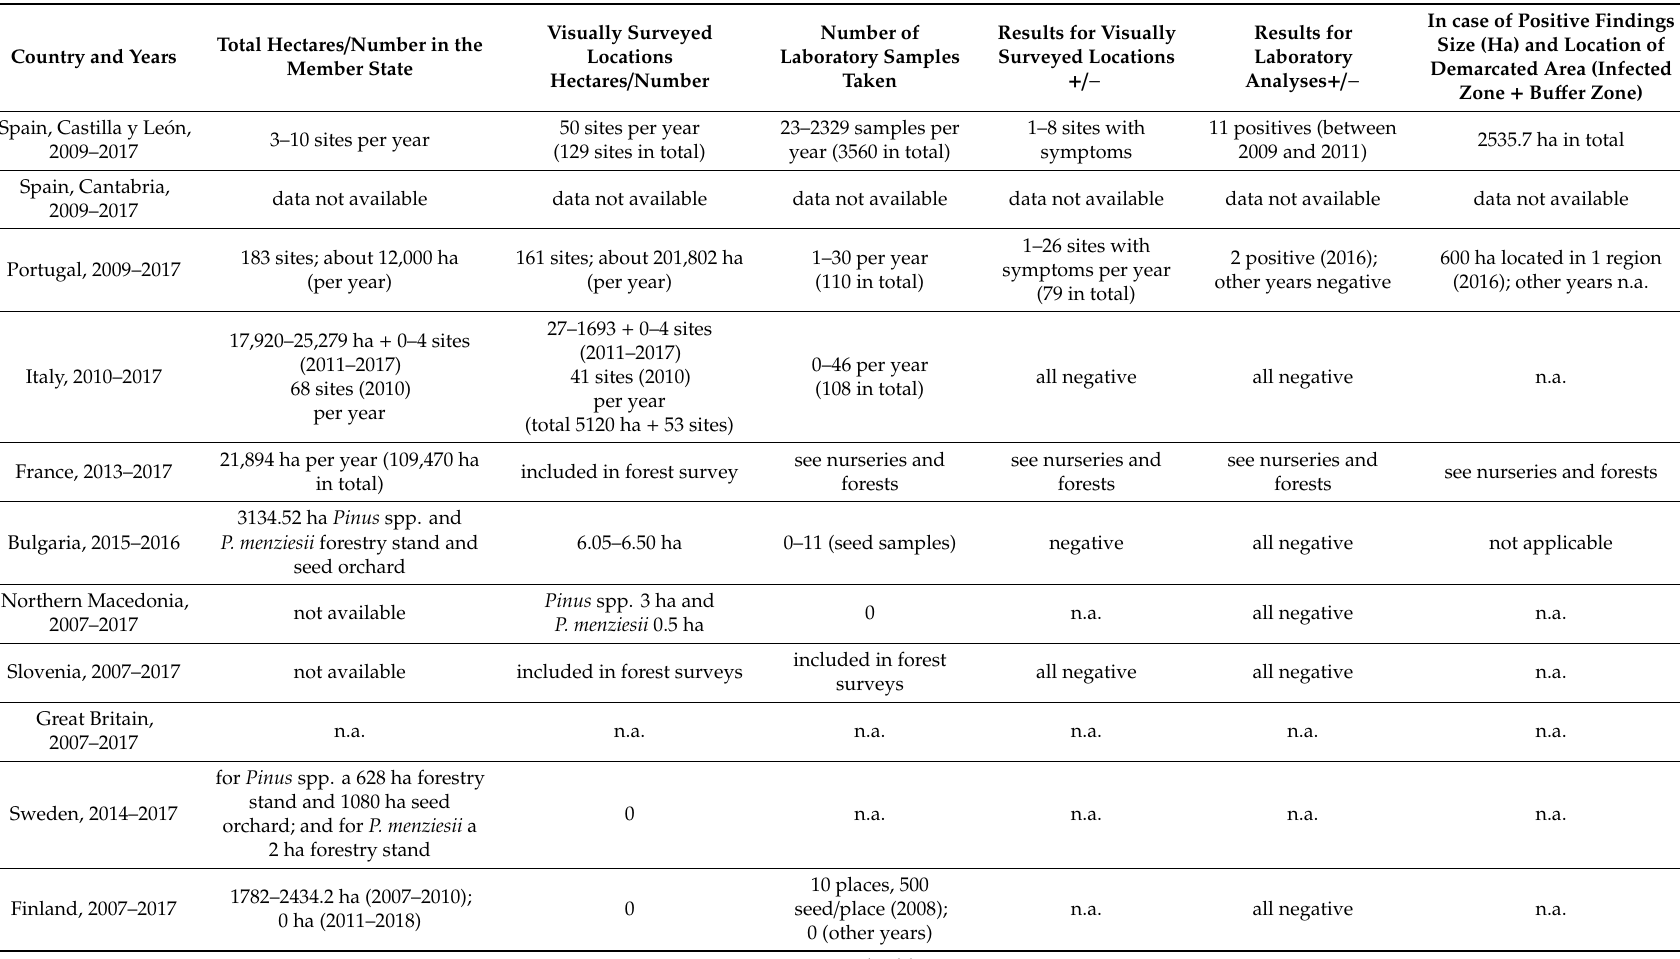
Table 2. Sampling approaches in production sites for planting material—demarcated Pinus spp. and Douglas-fir ( Pseudotsuga menziesii ) forest sites based on article 1 of the Commission Decision 2007 / 433 / EC (separate, demarcated part of forest where propagating material as seeds and cones were collected). The data is based on